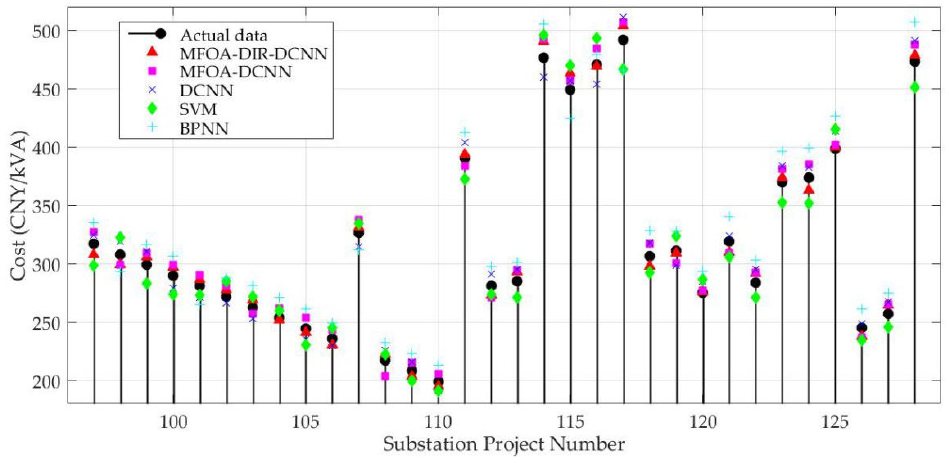
Figure 5. Forecasting results.